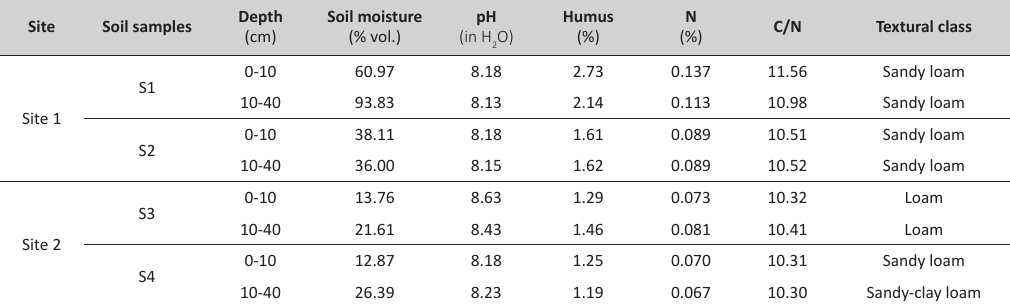
tABLE 1. Physical and chemical soil properties at the sites with irrigation (Site 1) and without irrigation (Site 2), at the Boulevard of Europe (Novi Sad, Republic of